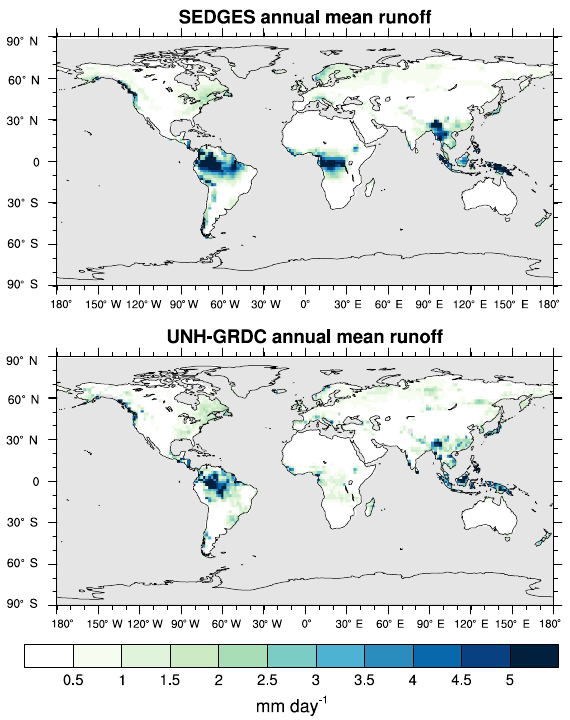
Figure 18. Climatological annual mean of runoff for SEDGES and the UNH-GRDC reference dataset (Fekete et al., 2002) over non- glaciated land.